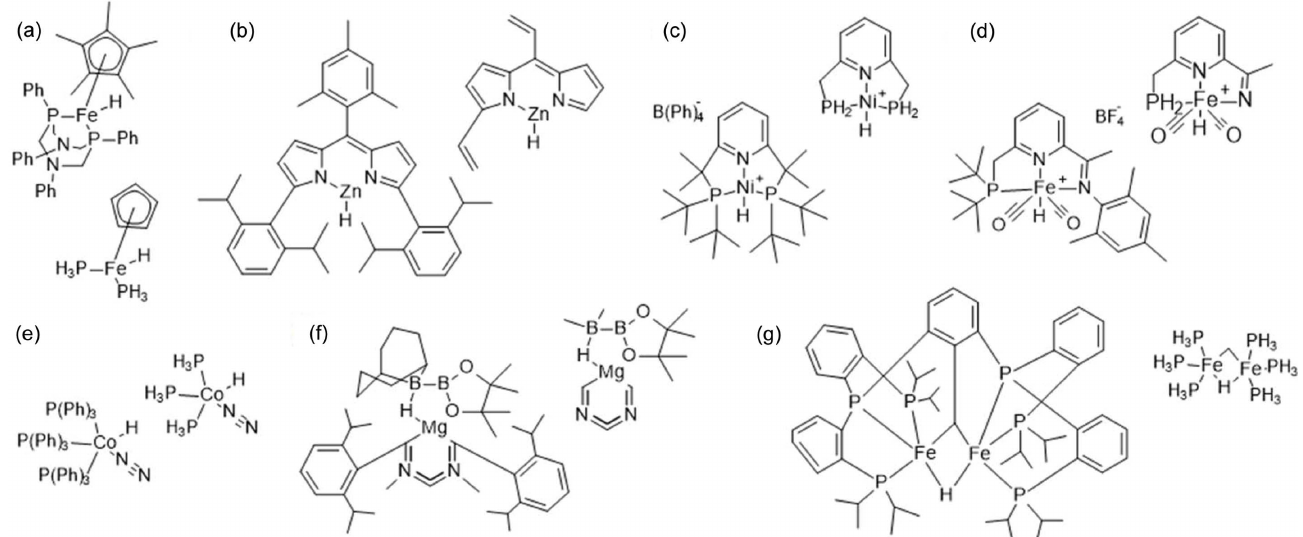
Figure 15 Metal–organic structures (whole system + fragment containing metal atom): ( a ) AHUKIZ, ( b ) LOKPOT, ( c ) MOVPIZ, ( d ) MUHBOI, ( e ) PPHCHN11, ( f ) QEPCOG, ( g )